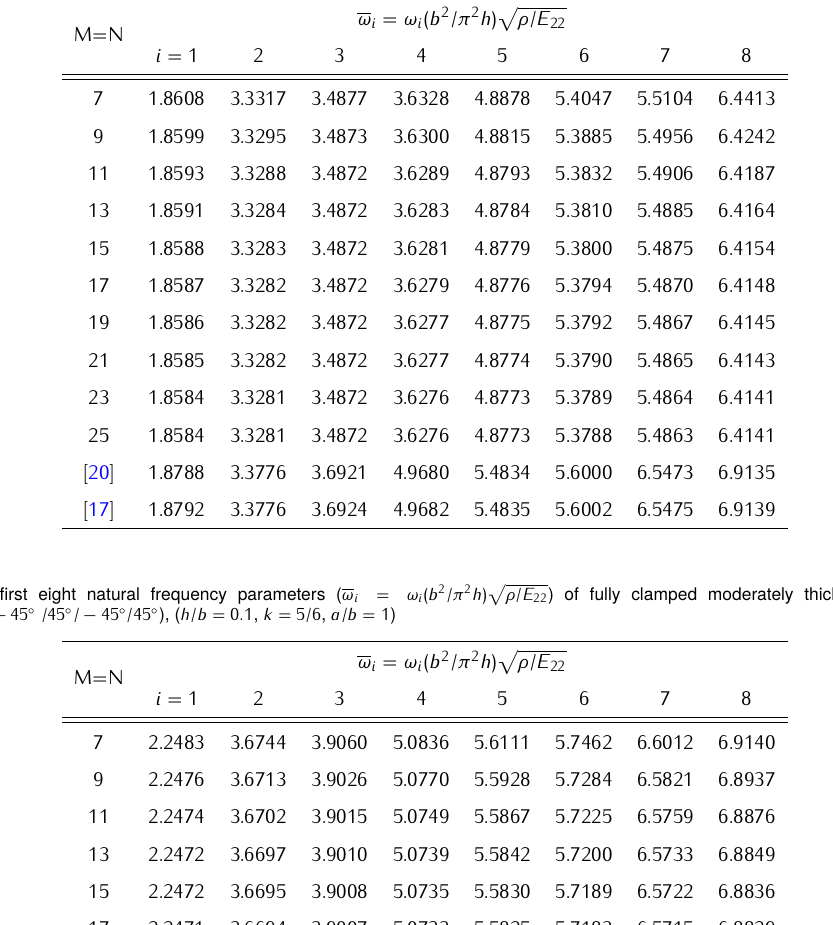
)p ρ/E Table 4. The first eight natural frequency parameters ( ω ) for simply supported boundary conditions of moderately thick i = ω i ( b 2 /π 2 h 22 anisotropic plates ( 45 ◦ / − 45 ◦ / 45 ◦ / − 45 ◦ / 45 ◦ ), ( h/b = 0 . 1 , k = 5 / 6 , a/b = 1 ) M=N